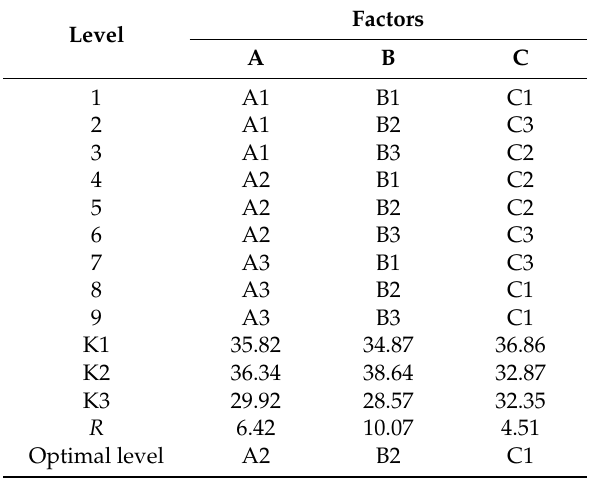
Table 3. The results of orthogonal experimental design L 9 (3) 3